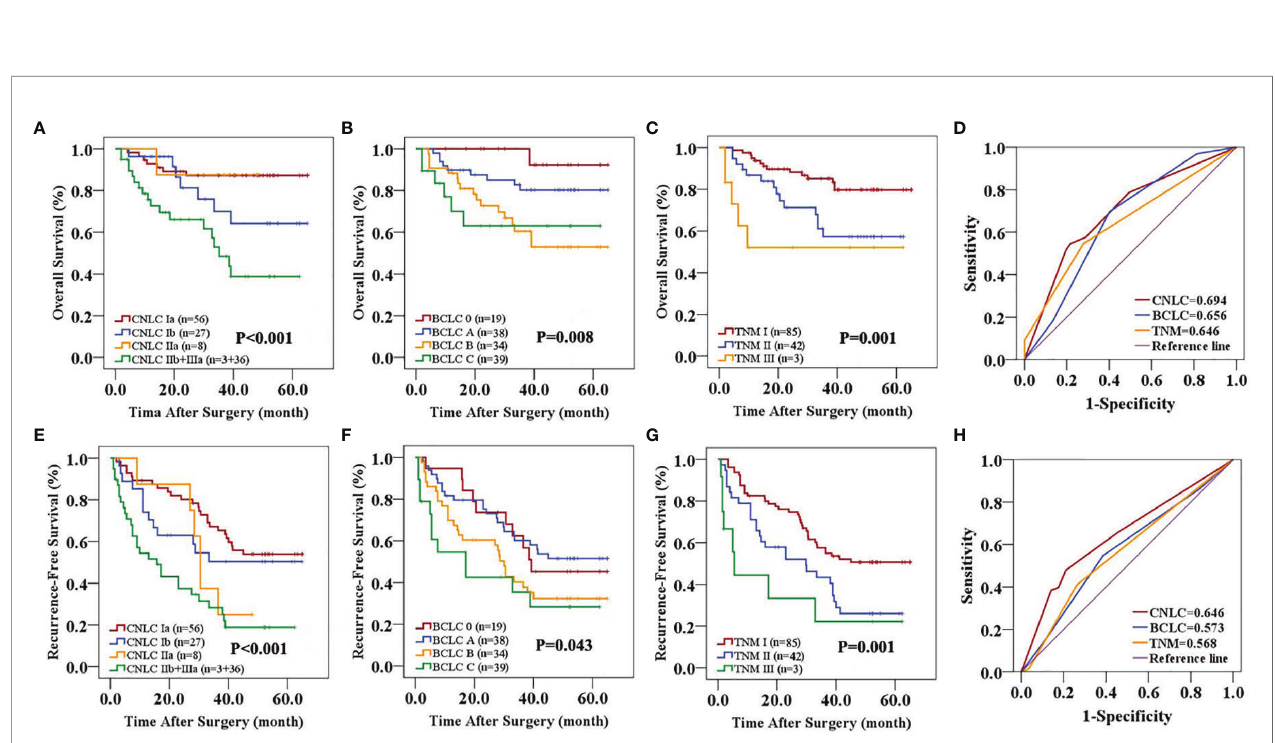
FIGURE 1 | Predictive accuracy comparison of the three staging systems for the prognosis of patients with HCC in the primary cohort. CNLC (A, E) , BCLC (B, F) and TNM 8th edition (C, G) staging systems are associated with OS (A – C) and RFS (E – G) of HCC after curative resection. ROC curves were used to compare the predictive accuracy of the three staging systems for assessing OS (D) and RFS (H) rates in the primary